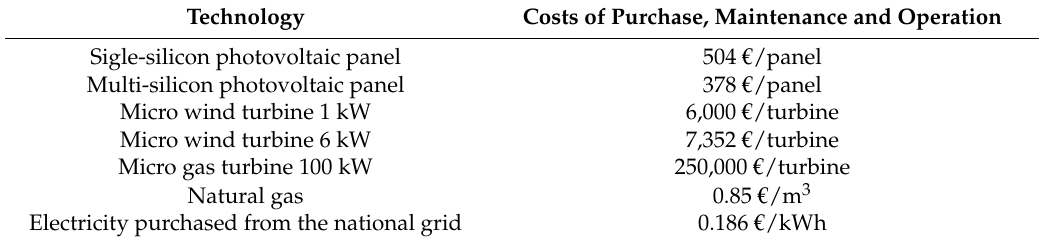
Table 2. Purchasing, maintenance and installation cost of the technologies object of study and user costs for electricity and natural